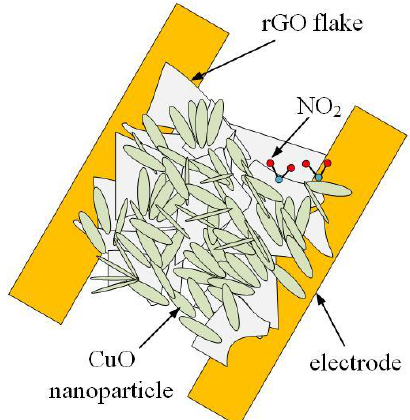
Figure 2. Schematic of the sample geometry illustrating the view of the upper two layers of the multilayer structure.